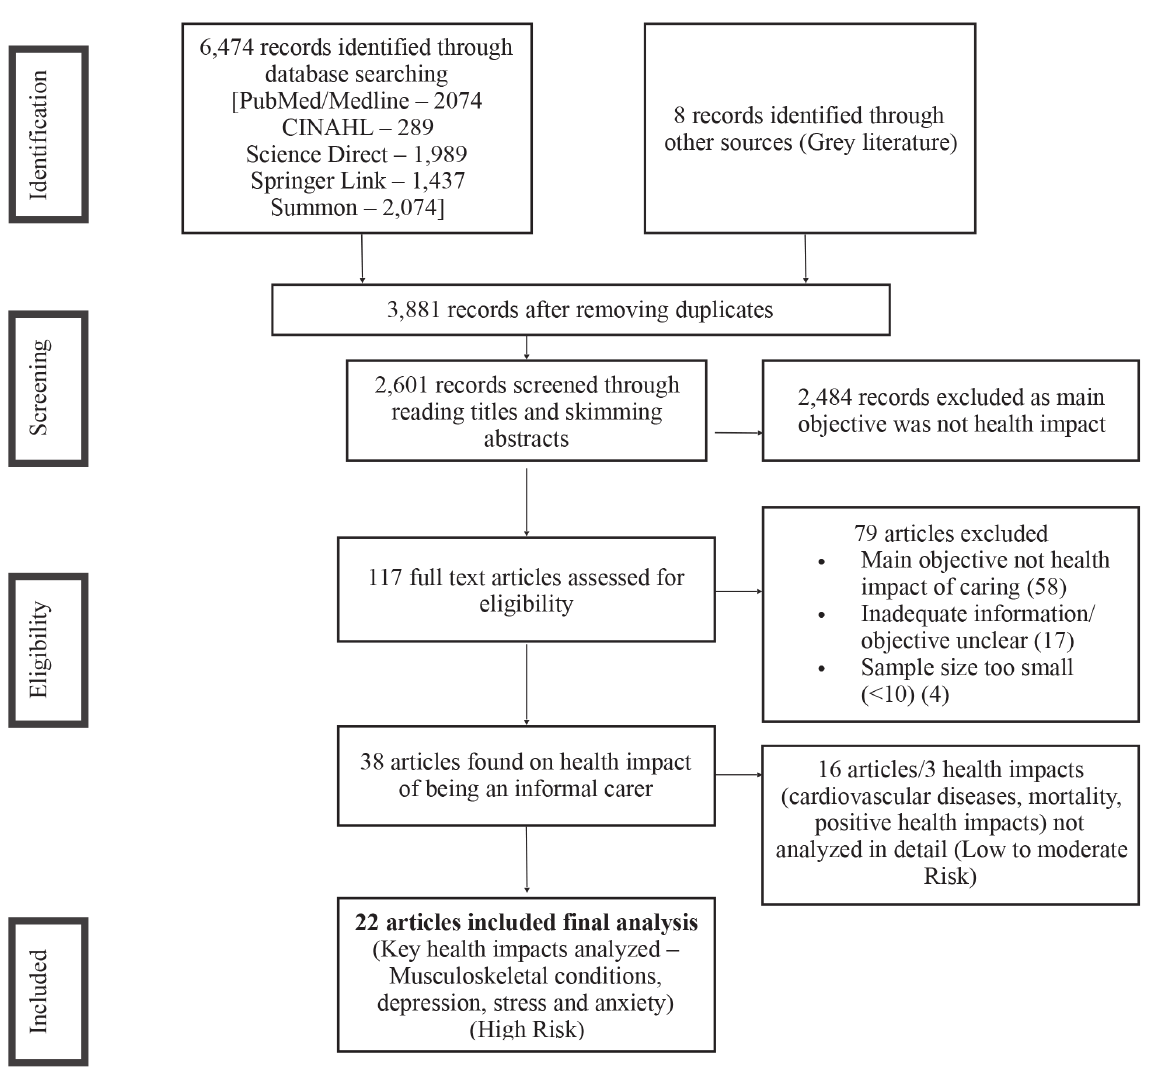
Figure 1. PRISMA flowchart of included